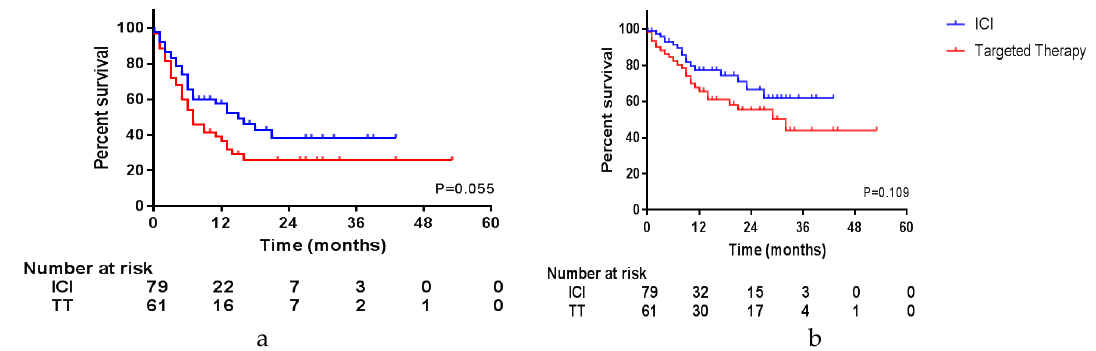
Figure 1. Survival per type of systemic therapy. ( a ) Progression-free survival; ( b ) overall